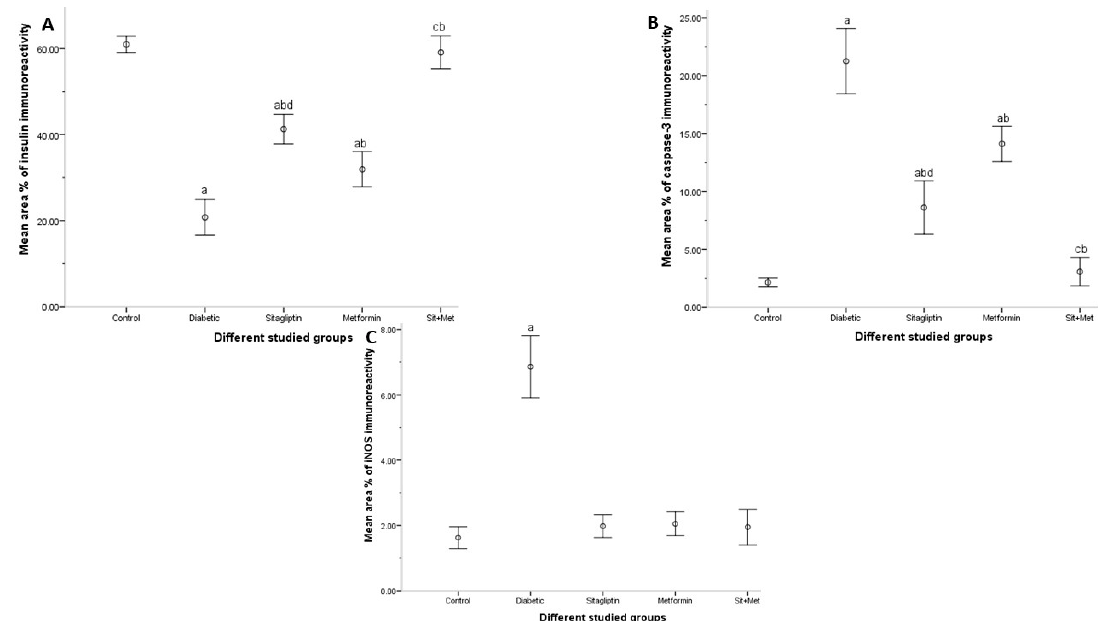
Figure 9. The area percent of insulin ( A ), caspase-3 ( B ), and iNOS ( C ) immunoreactivity in the di ff erent studied groups, at the end of the study period. The data were expressed as mean ± SD (n = 10). a : significantly di ff erent when compared to control, b : significantly di ff erent when compared to diabetic, c : significantly di ff erent when compared to sitagliptin and metformin, d : compared to metformin, using post hoc ANOVA (LSD), p < 0.05.